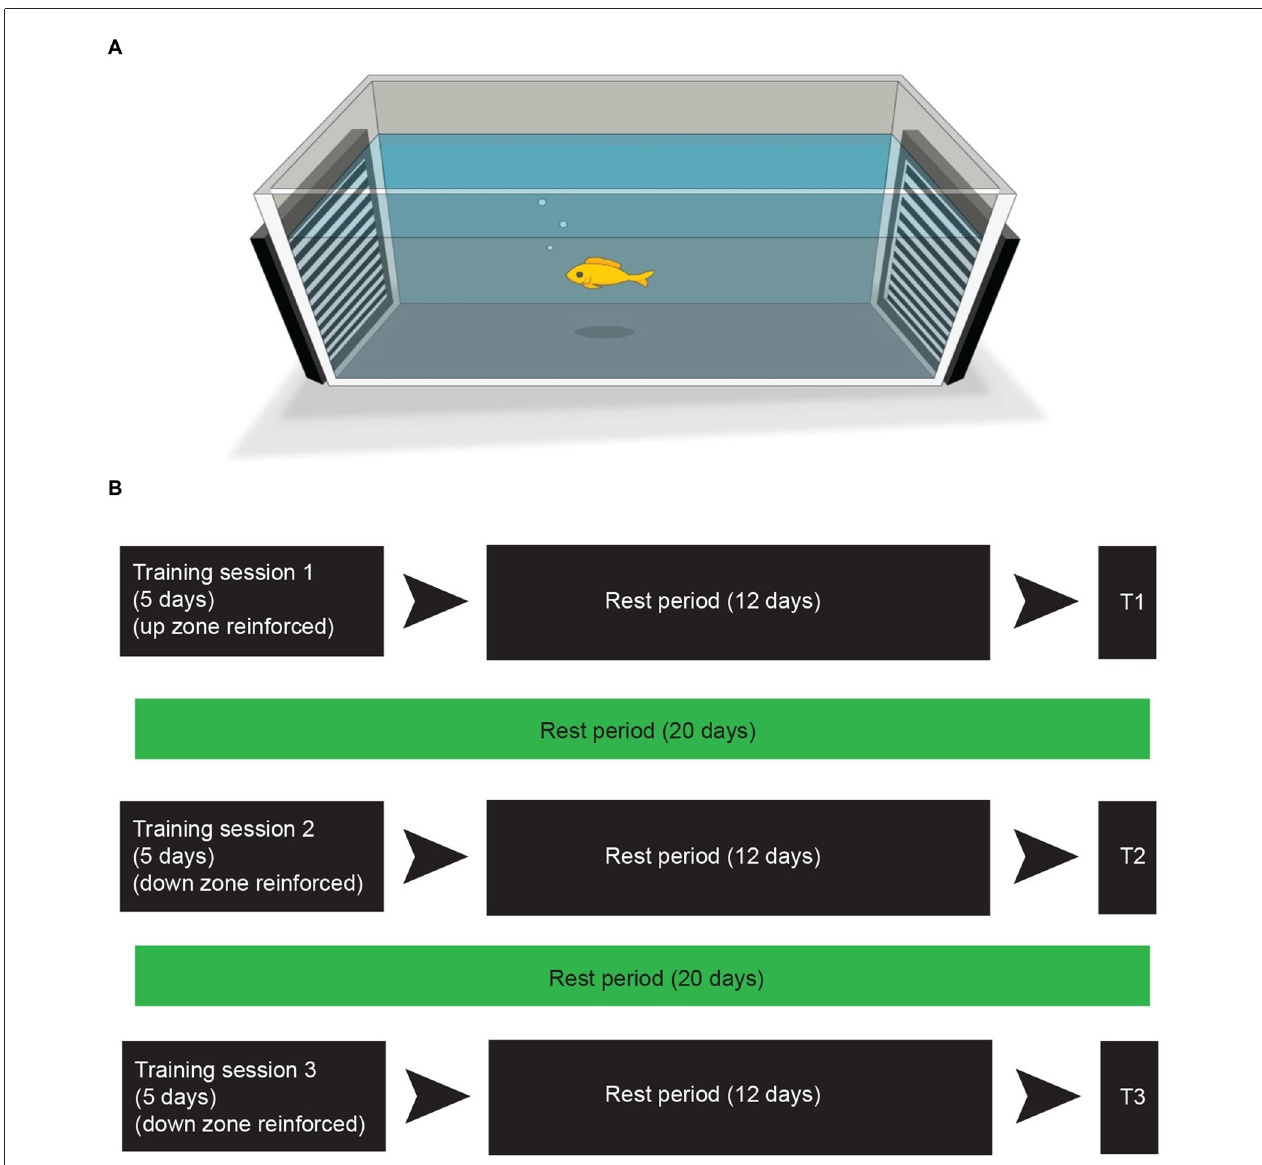
FIGURE 1 | Training leads to preference for reinforcement zone. (A) The apparatus used for training and testing. Computer screens on either end of the tank display drifting line gratings. See “Materials and Methods” Section for training and testing procedure. (B) The experimental training and testing schedule. In the first round of training fish were individually placed into the arena (A) and reinforced for moving into the “up zone” (within 25 cm of the moving stimulus) for 20 min per fish. This training took place 3 times in a 5-day period. The fish were then placed back into their community housing tank for 12 days (rest period). Test period 1 (T1) took place the day after the rest period. Following T1 the fish remained in their community housing tank for 20 days. The subsequent day training session 2 began and was identical to training session 1 with the exception of the reinforcement, which was switched to the “down zone”. Test period 2 (T2) was performed after a 12 day rest period. The third round of training and testing (T3) was identical to the second